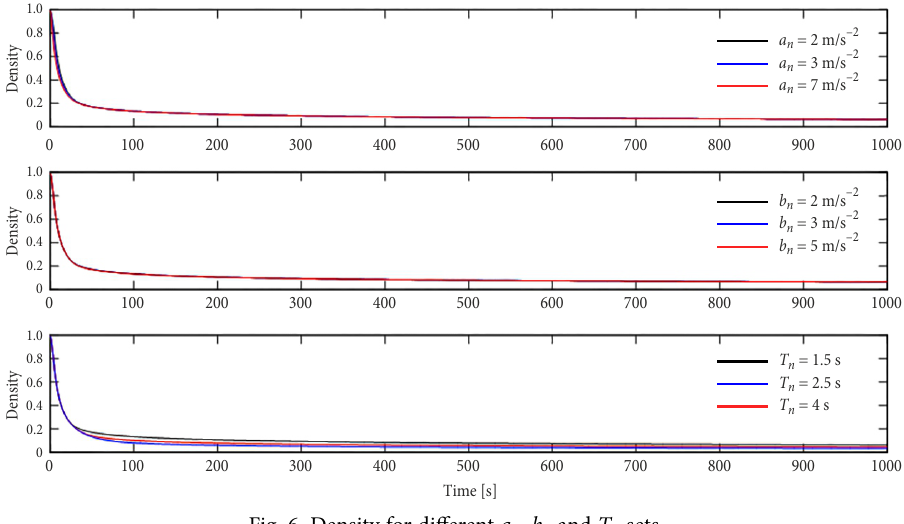
Fig. 6. Density for different a n , b n and T n sets